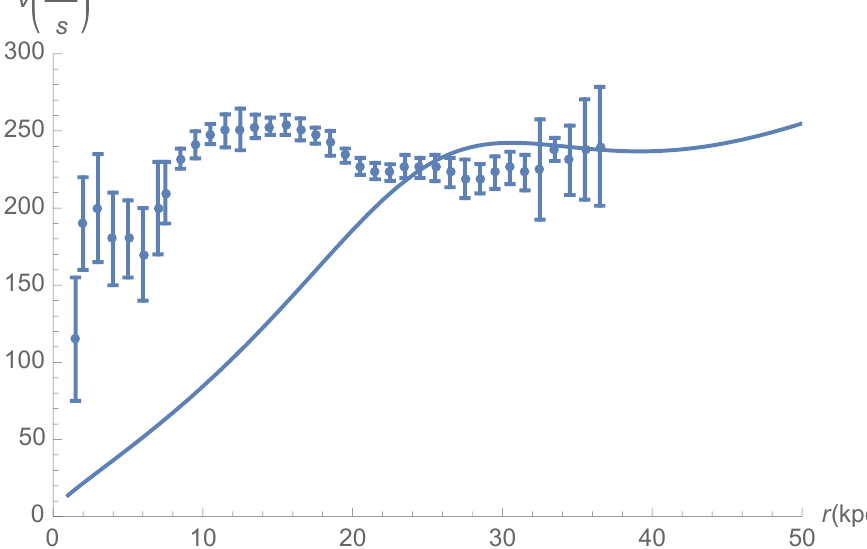
Figure 5. The rotational velocity curve for the galaxy M31. Dots are observed data [45], and the solid curve is the result of Equation (9) for the following parameters: Ω = 7, a = 1.2 × 10 3 , b = 2, c =